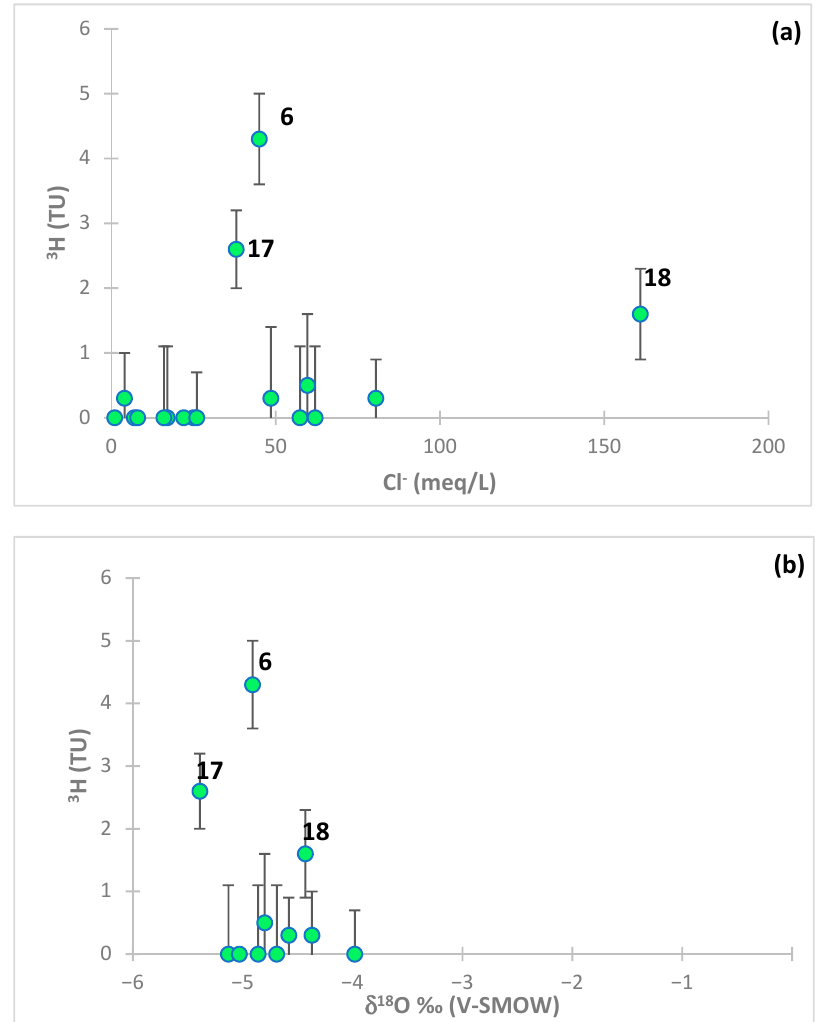
Figure 13. 3 H vs. Cl ( a ) and 3 H vs. δ 18 O ( b ) diagrams for groundwaters [23].